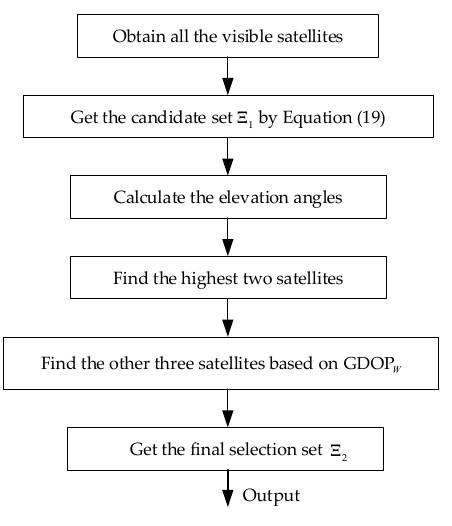
Figure 1. The flow chart of the proposed satellite selection.